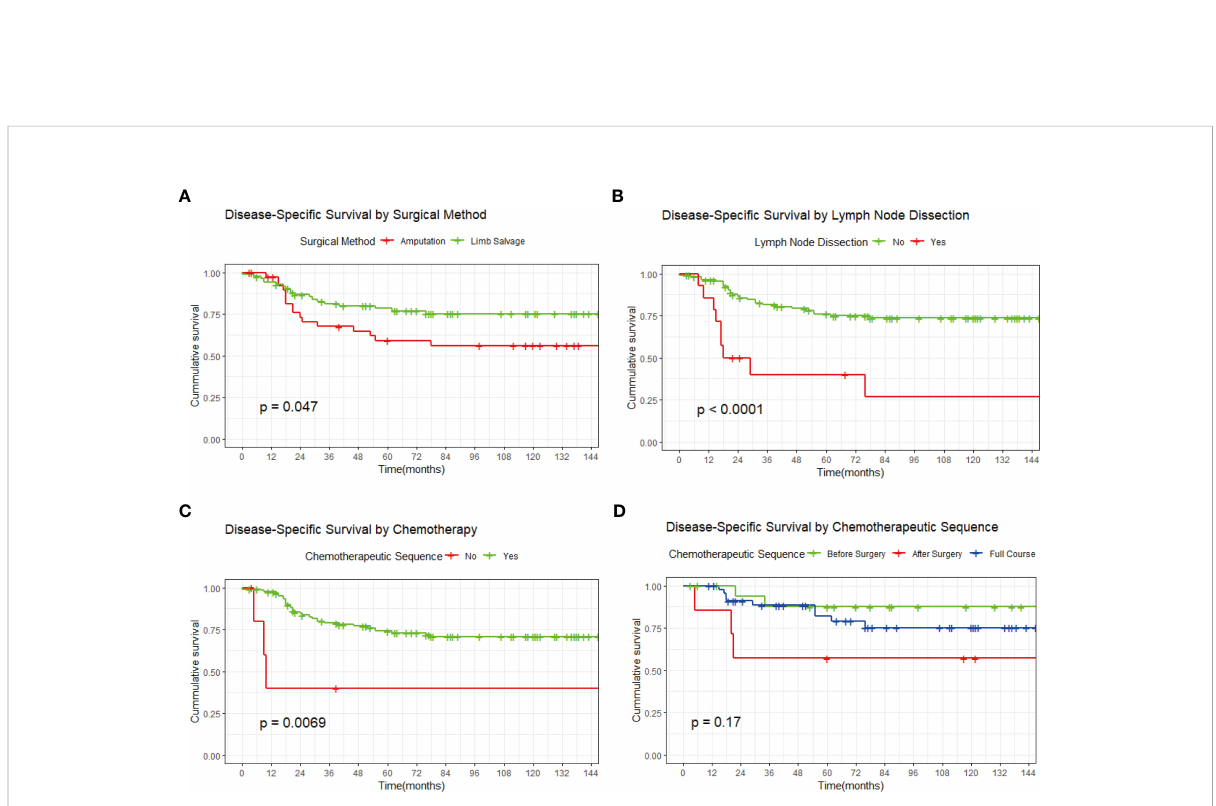
FIGURE 3 Kaplan-Meier survival curves. (A) By surgical method. (B) By additional regional lymph node dissection. (C) By adjuvant chemotherapy. (D) By chemotherapy sequence.